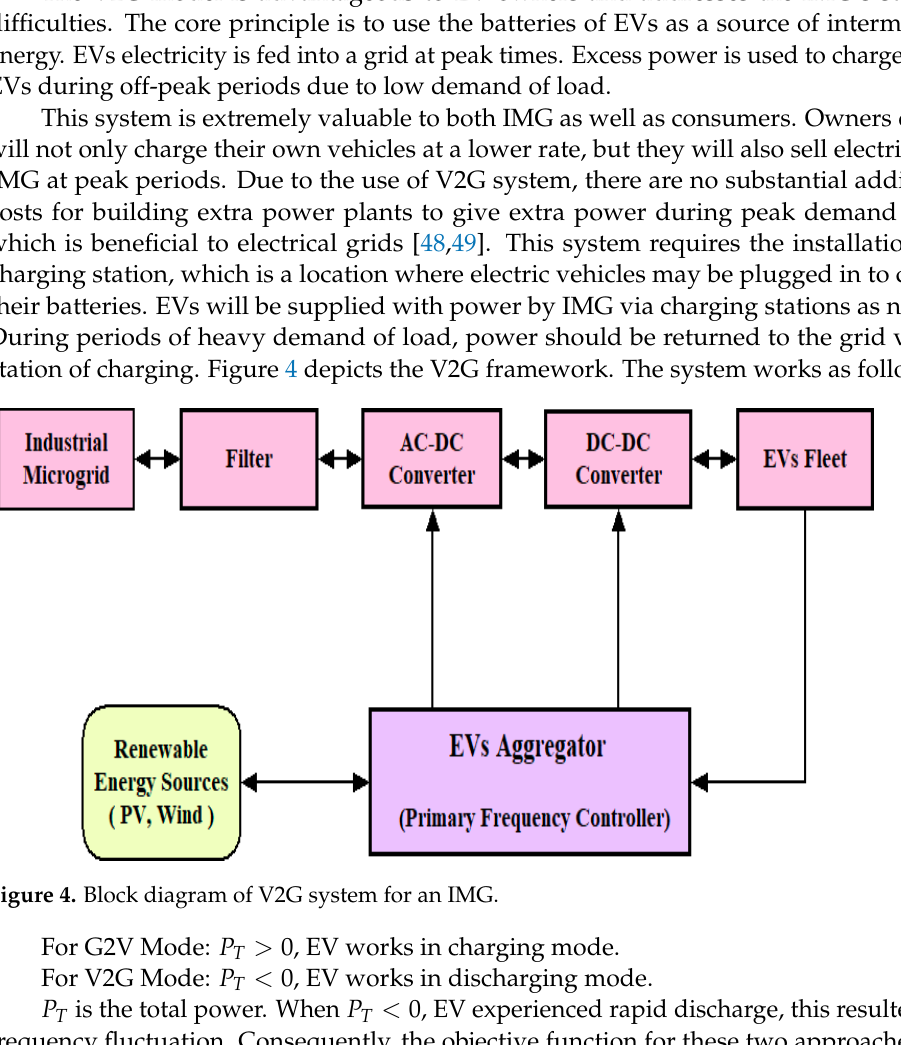
Figure 4. Block diagram of V2G system for an IMG.